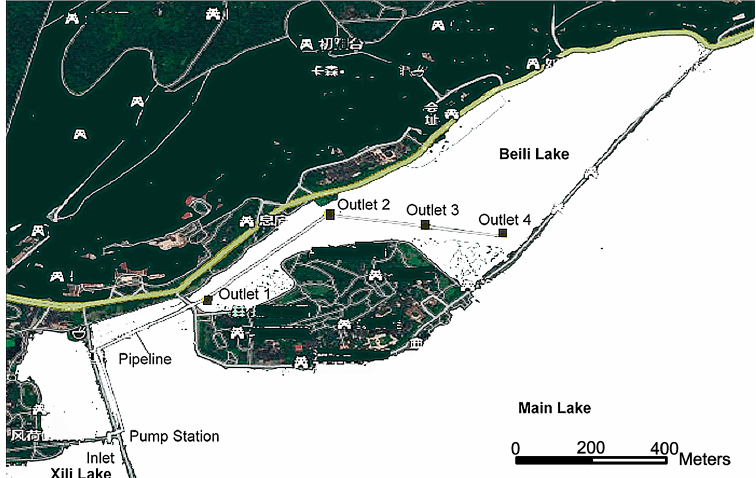
Figure 4. Layout of diversion and water distribution for Beili Lake.